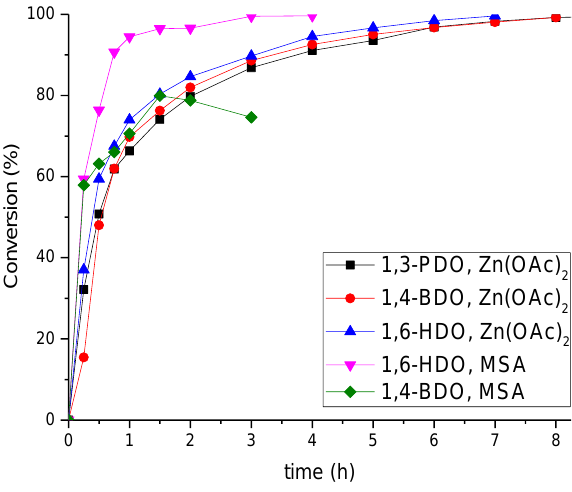
Figure 6. Conversion curves of the polycondensation reactions of itaconic acid with 1,3-propanediol, 1,4-butanediol, and 1,6-hexanediol in the presence of MSA or Zn(OAc) 2 .